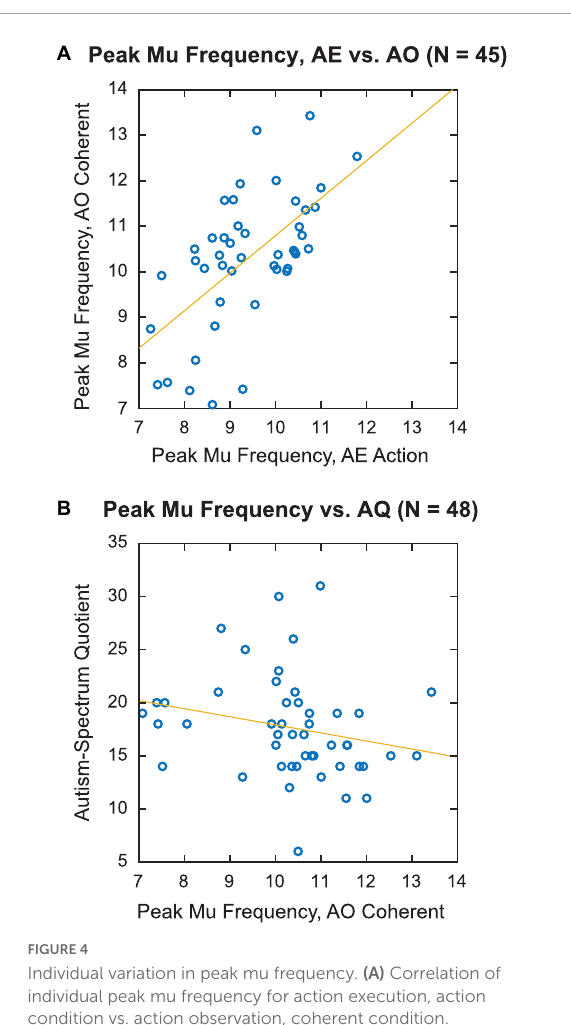
FIGURE4 Individual variation in peak mu frequency. (A) Correlation of individual peak mu frequency for action execution, action condition vs. action observation, coherent condition. (B) Individual peak mu frequency for action observation, coherent condition vs. autism-spectrum quotient (AQ)